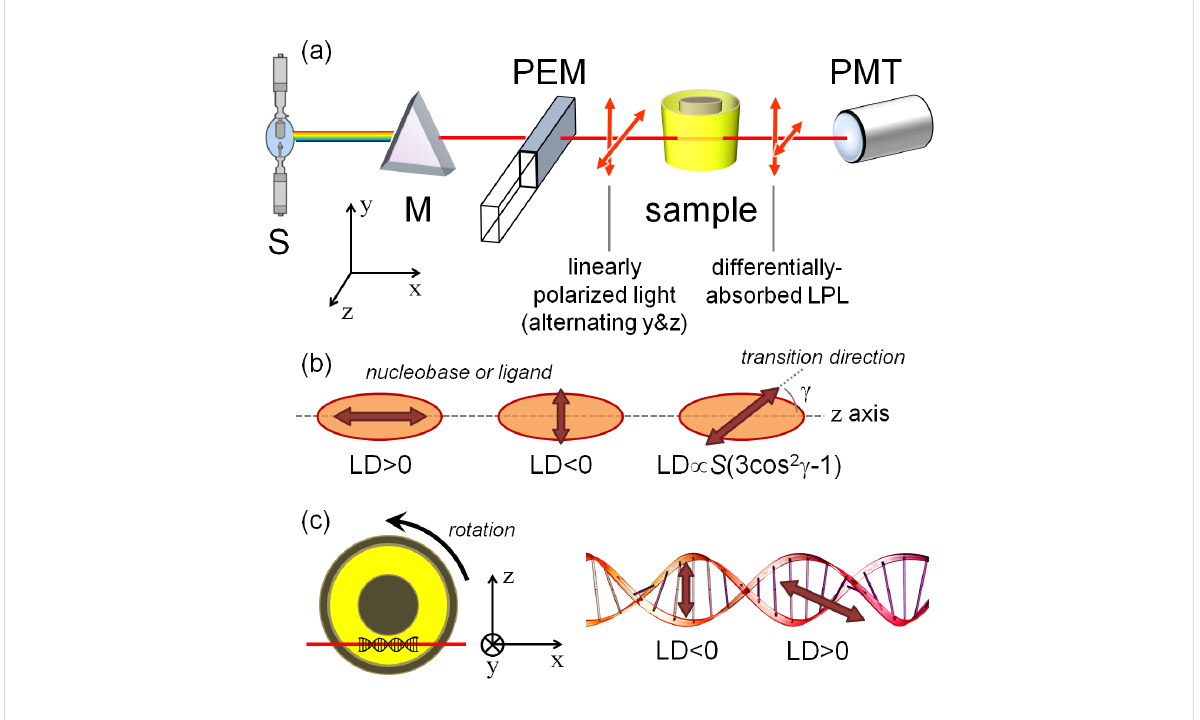
Figure 9: a) Schematic diagram of a flow LD instrument. b) Definition of the optical factor relating the direction of sample transition moment and the macroscopic sample orientation. The formula refers to a uniaxial sample; S is the orientation parameter, which quantifies the extent of effective sam- ple orientation. c) Schematic illustration of a Couette flow LD experiment applied to a DNA/ligand complex.